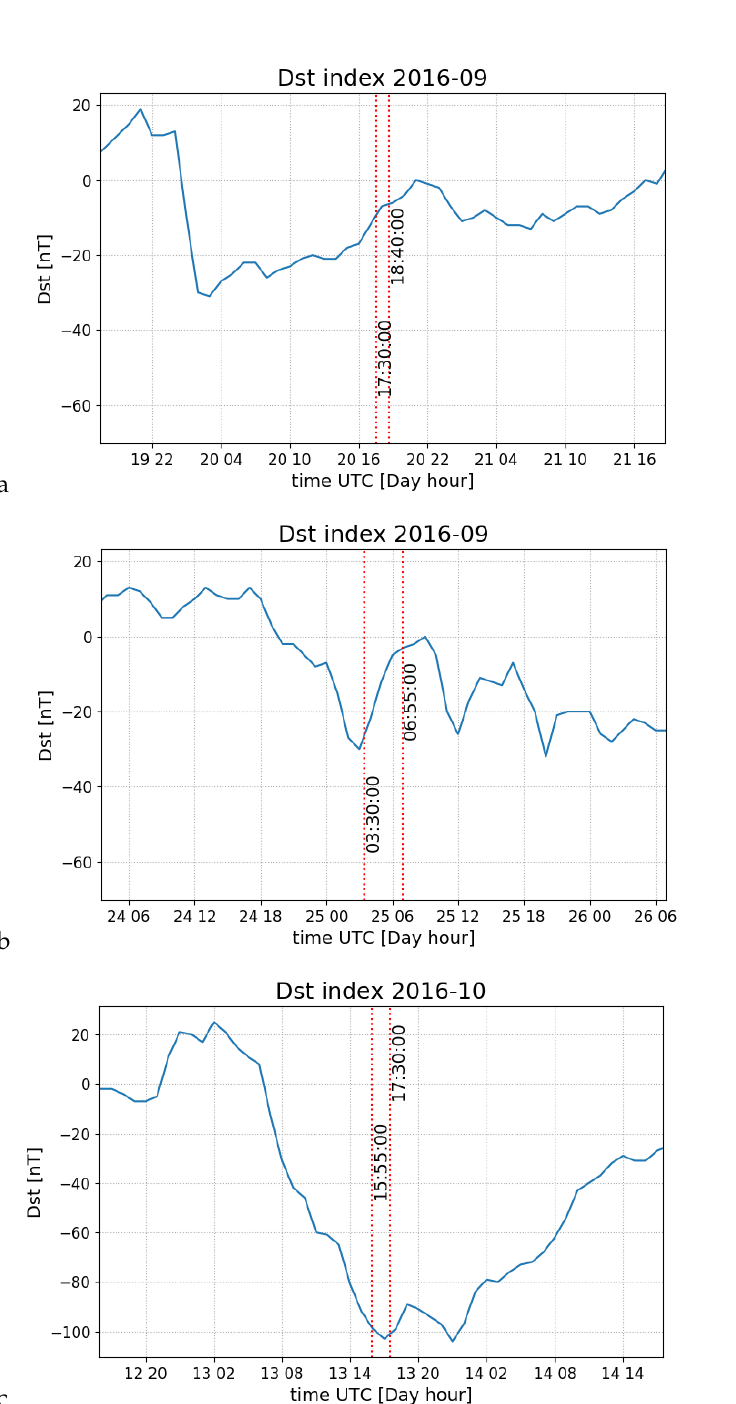
Figure 5. Dst index for considered datasets: ( a )—L547449; ( b )—L547785; ( c